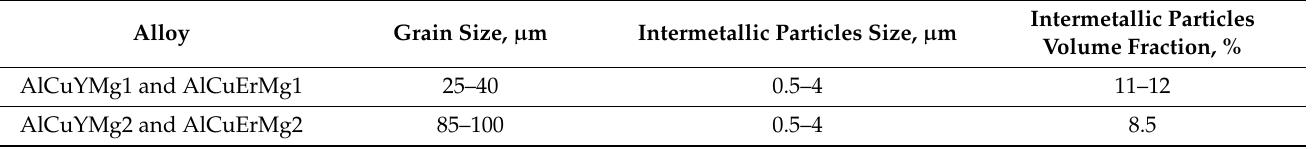
Figure 1. Microstructure of the AlCuErMg2 alloy in the as-homogenized state: ( a ) LM and ( b ) SEM. Table 2. Microstructure parameters.